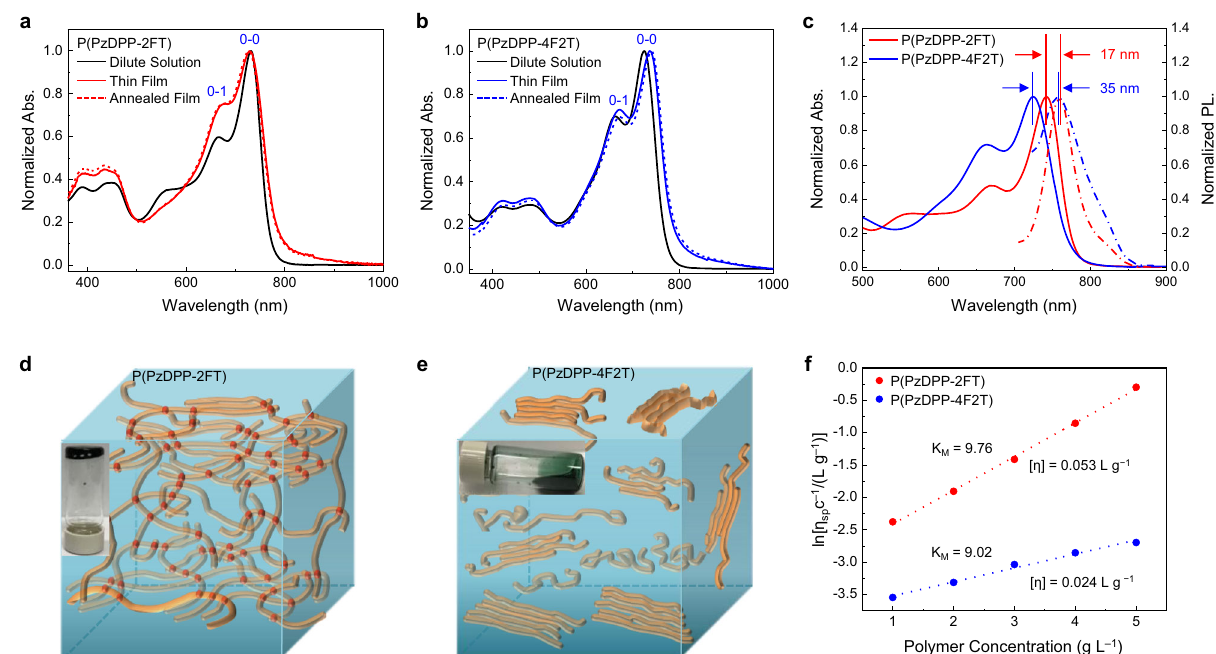
Fig. 2 Comparison of the optical properties, the microstructures, and interchain interactions. a , b Normalized absorption spectra of both P(PzDPP-2FT) and P(PzDPP-4F2T) in solution, thin fi lm, and annealed fi lm. c Normalized absorption (solid lines) and photoluminescence (dash lines) ( λ ex = 460 nm) spectra of the polymer solutions. d , e Schematic illustration of the possible microstructures of both polymers in solution. The red dot in the fi gure represents the crosslinking points or strong interchain short contacts. f Viscosity comparison of both polymer solutions as a function of concentration at 20